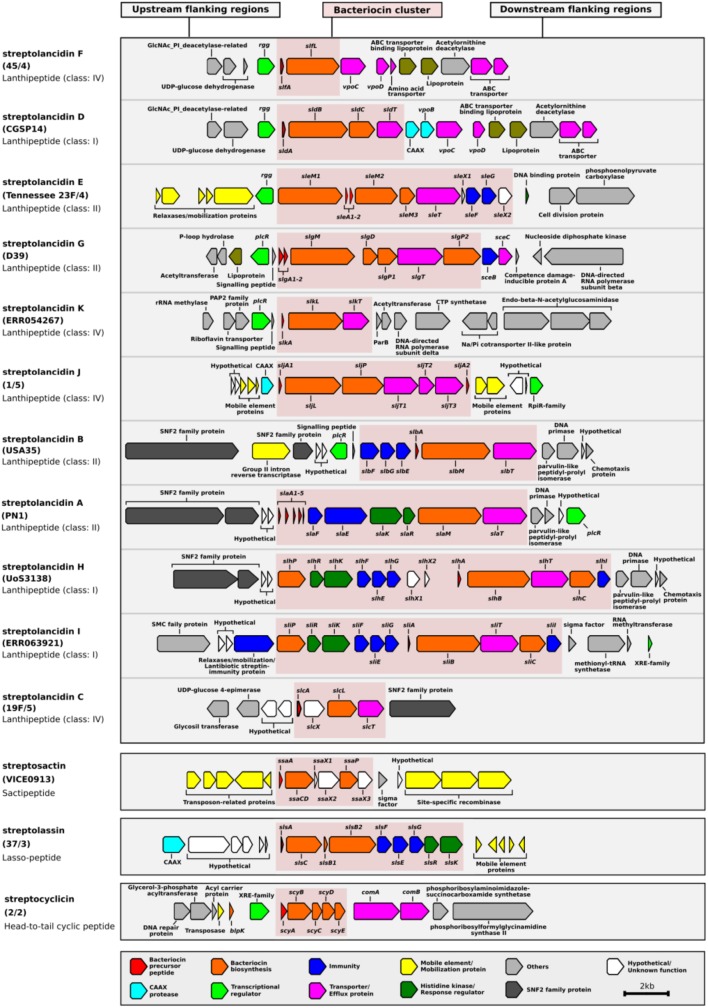
Genetic composition of streptolancidin, streptocyclicin, streptosactin, and streptolassin bacteriocins in the pneumococcal genomes. A schematic representation of 11 different streptolancidins, one streptocyclicin, one streptosactin, and one streptolassin identified among pneumococcal genomes is depicted. The names of the isolates containing each bacteriocin cluster are given in brackets and the class of each bacteriocin cluster is given underneath the names of isolates.